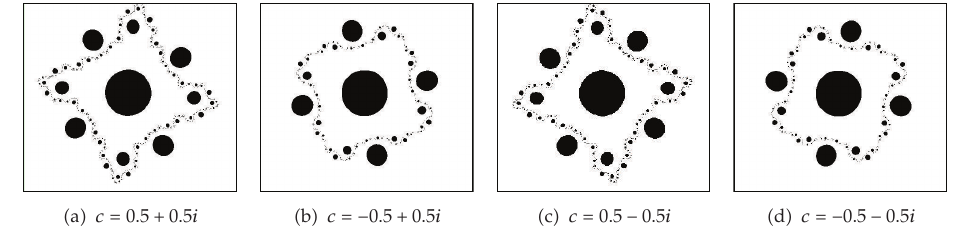
Figure 3: The generalized J sets without any perturbation when α (cid:6) − 4.